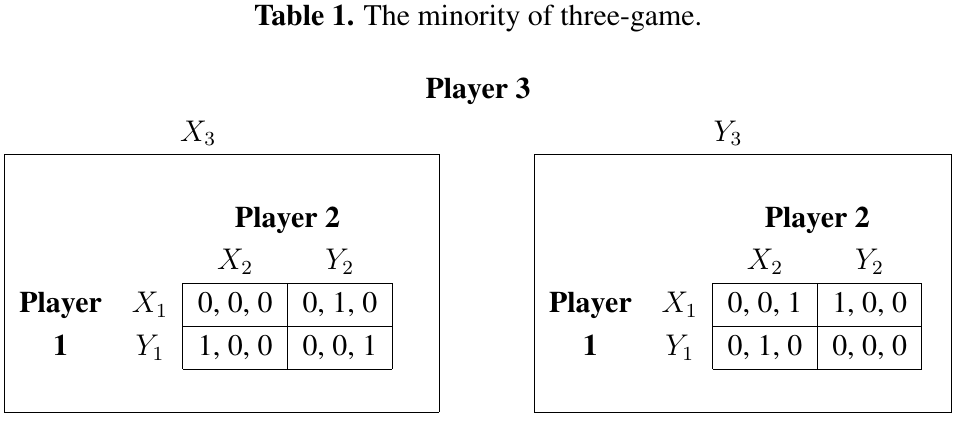
Table 1. The minority of